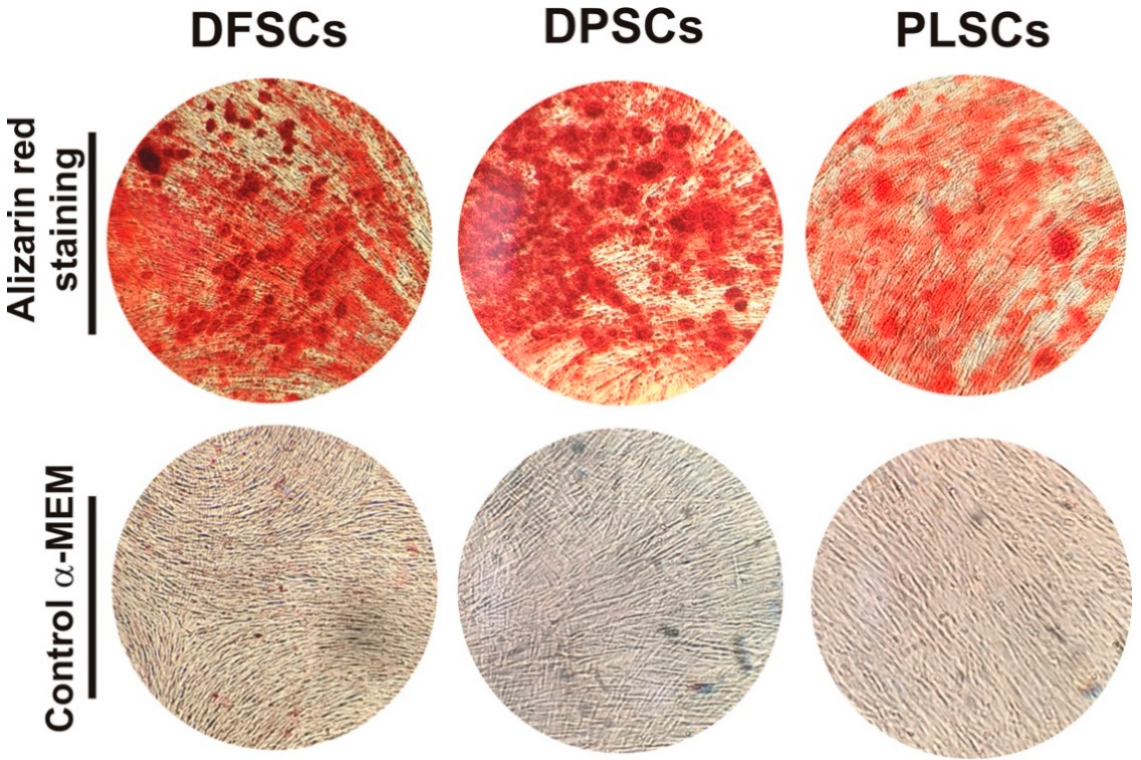
Figure 4. Osteogenic differentiation of DT-MSCs. Osteogenic capacity of dental follicle stem cells (DFSCs), dental pulp stem cells (DPSCs), and periodontal ligament stem cells (PLSCs) determined by calcified mineralized matrix staining with alizarin red after 14 days of induction. No staining was detected in the culture of each dental stem cell in the absence of osteogenic